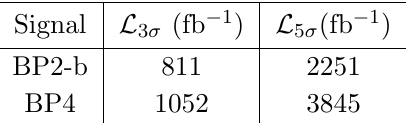
Table 14 . Required luminosities for discovery of same sign di-lepton (cid:12)nal states with missing p energy at s = 13 TeV